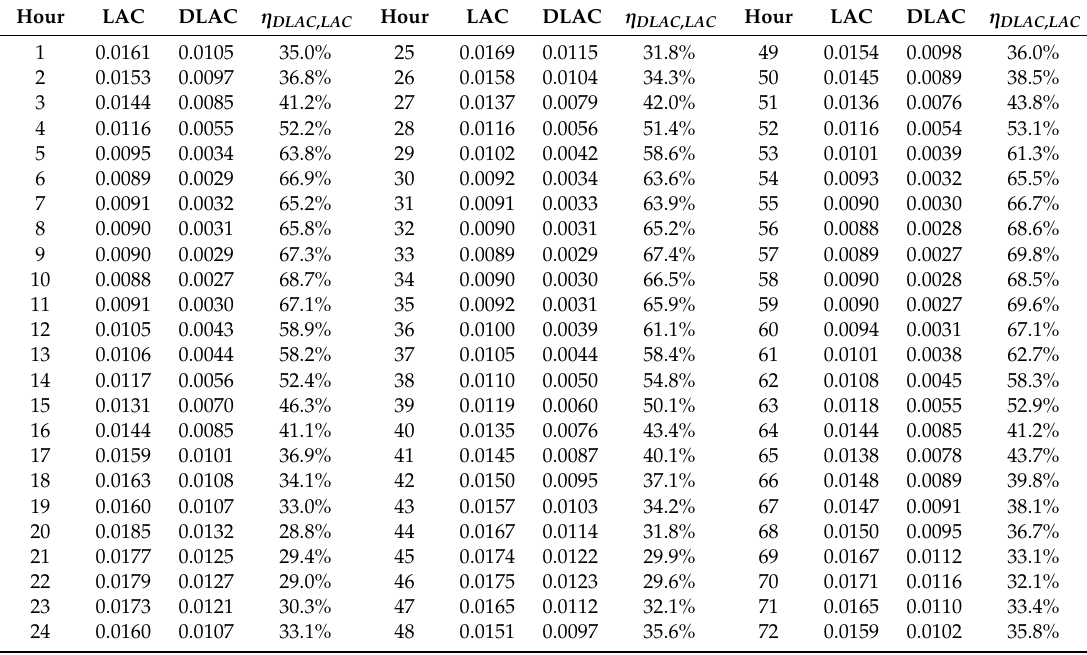
Table 14. Improvement of Voltage Magnitude for 72 Consecutive Cases.